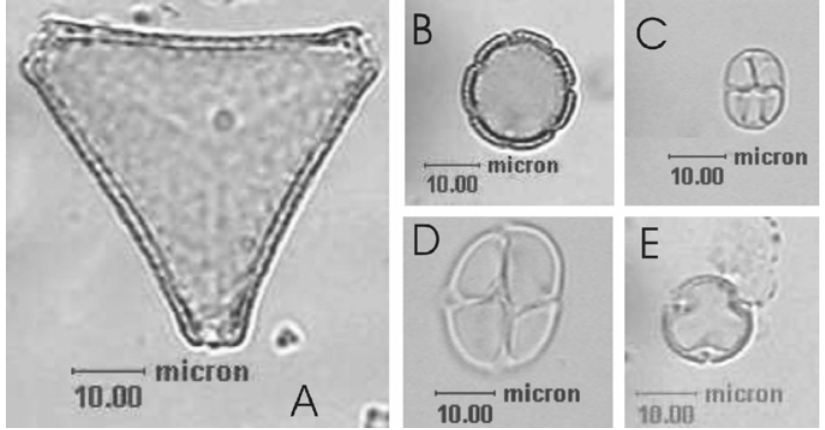
Fig. 1 – Dominant pollen types found in 20 Apis mellifera honey samples from the State of Ceará. A – Serjania sp. (Sapindaceae); B – Borreria verticillata (Rubiaceae); C – Mimosa